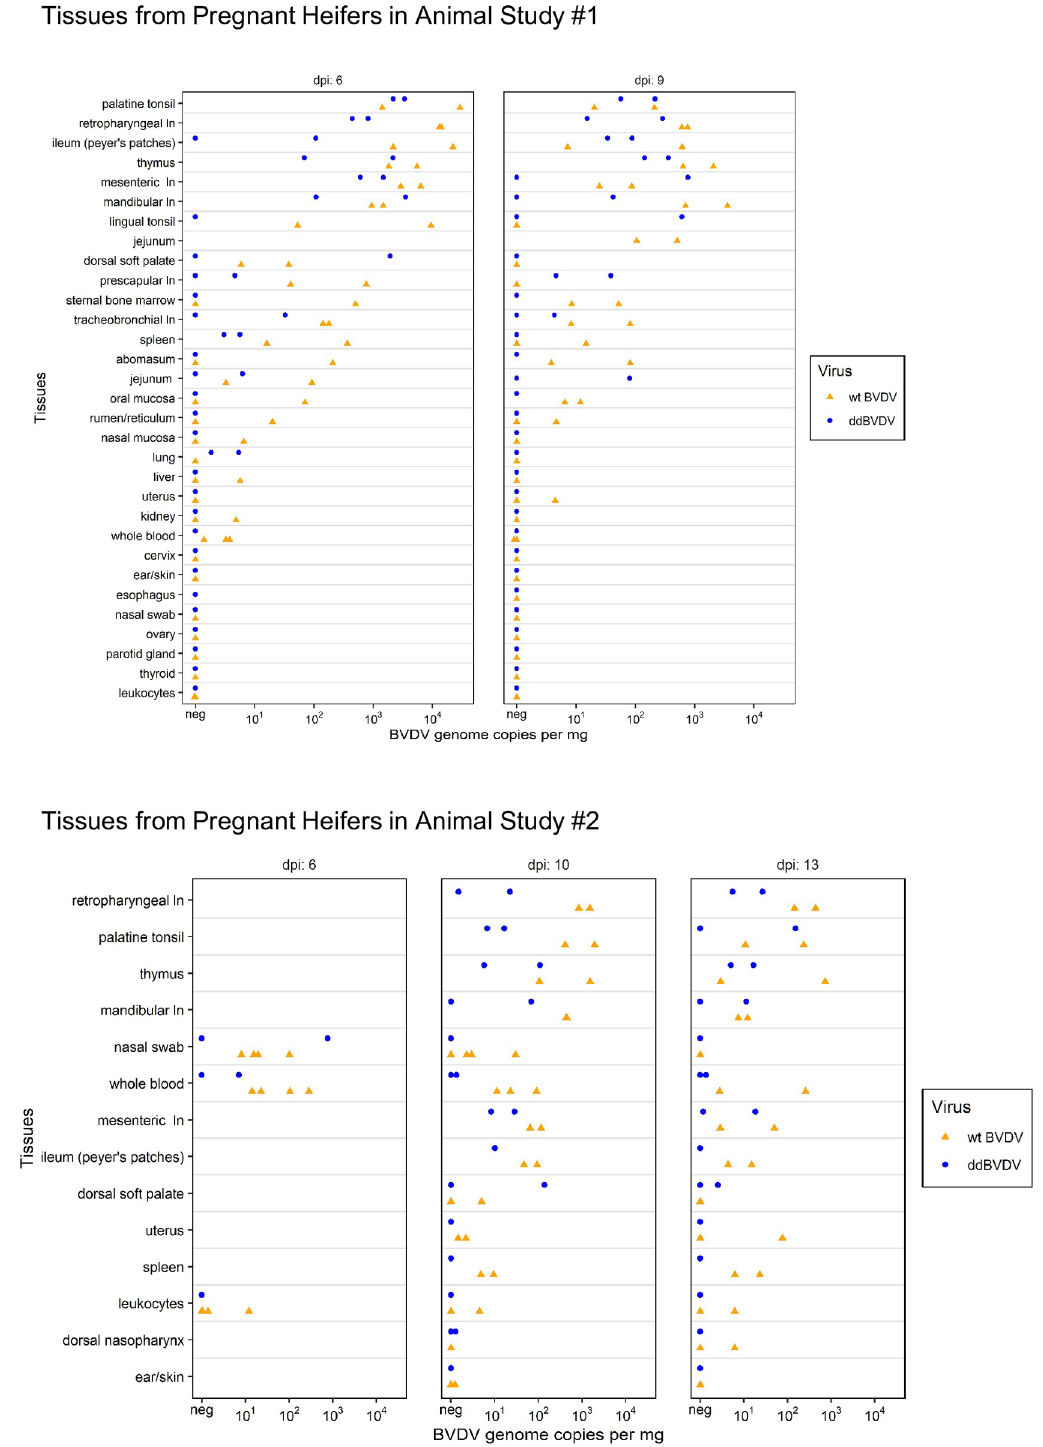
Fig 5. Detection and quantification of BVDV genome in tissues of the heifers. Orange triangles and blue dots indicate the animals infected with wt BVDV or ddBVDV, respectively. The positioning of the triangles and dots reflects the amount of viral RNA detected in copy number per mg total